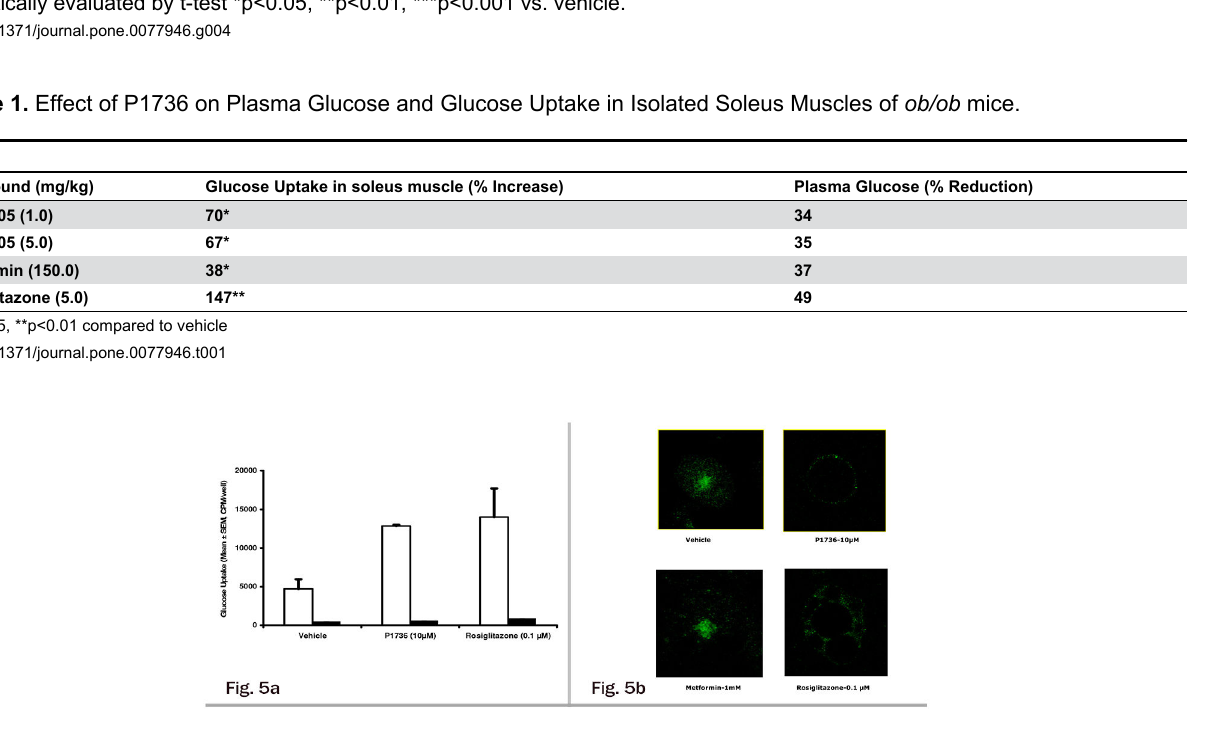
Figure 5. P1736 promotes glucose uptake by modulating insulin signaling pathways. a , Effect of P1736 on PI3 - Kinase mediated glucose uptake in insulin resistant 3T3 adipocytes. Insulin resistant adipocytes were treated with P1736 (10 μM) or rosiglitazone (0.1 μM) as mentioned in methods. At the end of 4 days, cells were treated with vehicle (empty bar) or 100 nM wortmannin (solid bar) for 30 minutes. Later 200nmol/l insulin stimulated 2-deoxyglucose uptake was determined. b , Effect of P1736 on GLUT-4 translocation in insulin resistant adipocytes. Insulin resistant 3T3 adipocytes were treated with vehicle or P1736 (10 μM) or Metformin (1 mM) or rosiglitazone (0.1 μM) for 4 days. Later the cells were stimulated with 200nmol/l insulin for 25 minutes. Whole cell immunofluorescence assay for GLUT-4 translocation was performed using rabbit antibody against GLUT - 4 followed by incubation with FITC labeled secondary antibody. Confocal images were obtained using Bio-Rad Laser Scanning Microscope. doi: 10.1371/journal.pone.0077946.g005 Figure 5b. In the same study, metformin (1 mM) was inactive When P1736 was screened against a panel of membrane while rosiglitazone (0.1 µM) also caused GLUT-4 translocation receptors, ion channels and enzymes no significant activity was (Figure 5b). detected against any target including PTP-1B and AMPK. The